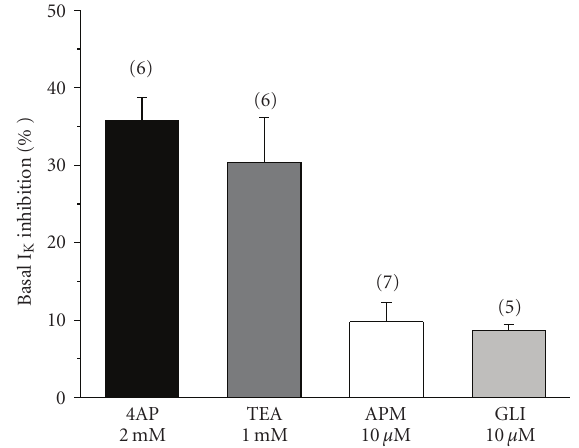
Figure 6: E ff ect of di ff erent potassium channel blockers on I K in A7r5 cells. The bars represent the e ff ect on I K of the following potas- sium channel blockers: the K V channel blocker 4-aminopyridine (4- AP; 2mM); the BK Ca channel blocker tetraethylammonium (TEA; 1mM); the low-conductance K Ca channels blocker apamin (APM, 10 μ M); and the K ATP channel blocker glibenclamide (GLI; 10 μ M). Each column represents the mean value ± SEM (indicated in vertical bars), in percent of the inhibition of I K from the number of experiments shown in